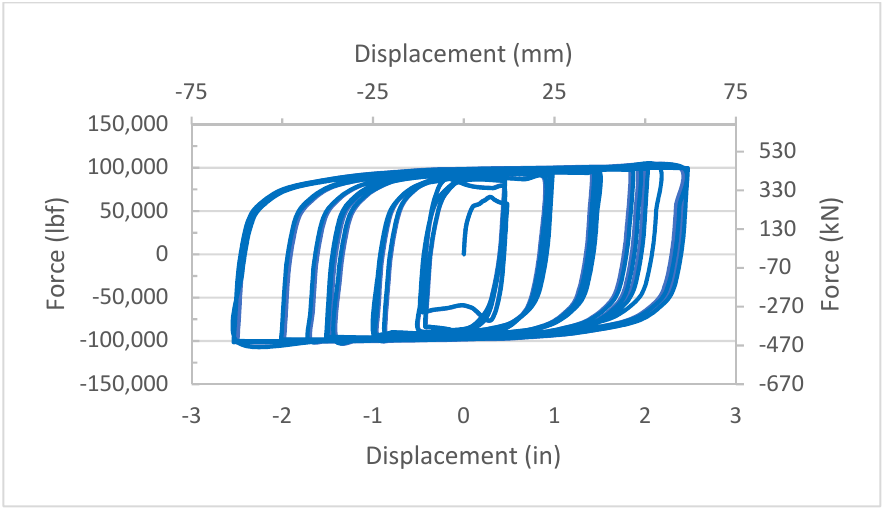
Figure 10. FEM results—vertical force vs vertical displacement for MYZ connector.